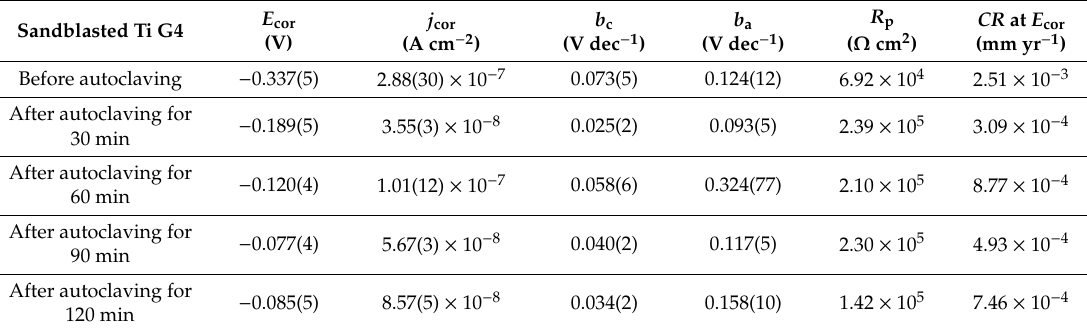
Table 8. Corrosion resistance parameters determined based on the Tafel extrapolation method of the polarization curves for the Ti G4 electrodes before and after autoclaving immersed in ASS at 37 ◦ C (see Figure